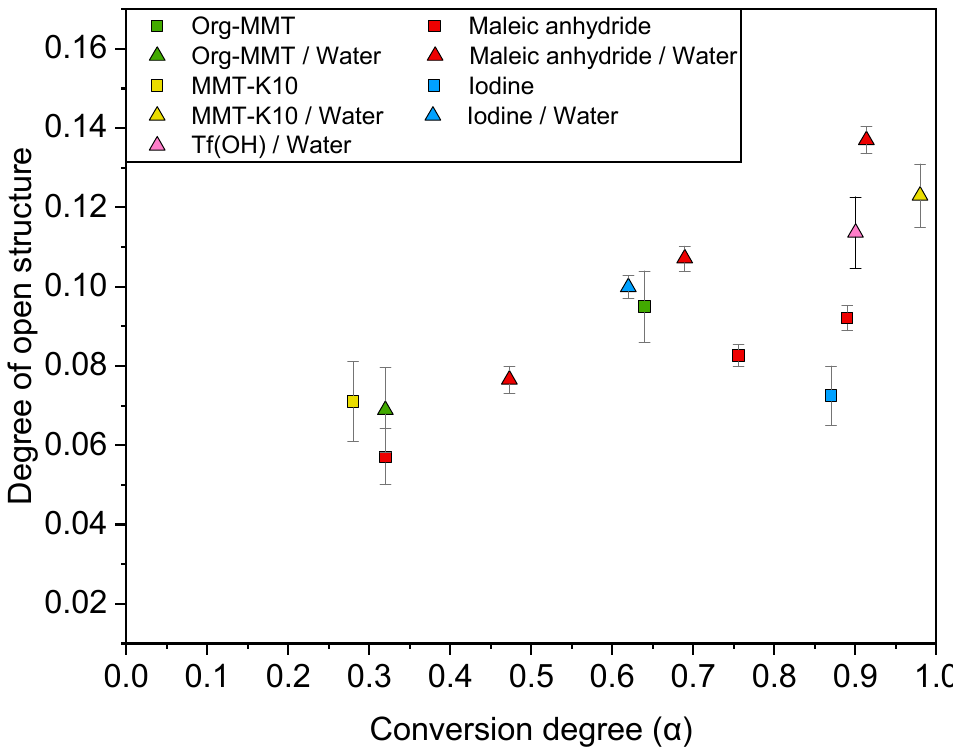
Figure 2. Comparison of the degree of open structures obtained by titration method and synthesized with different initiators with and without additional water (50/50 w / w ) as function of the conversion degree.